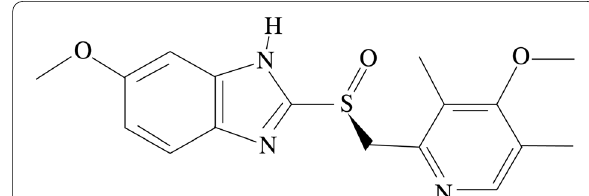
Fig. 1 Chemical structure of esomeprazole